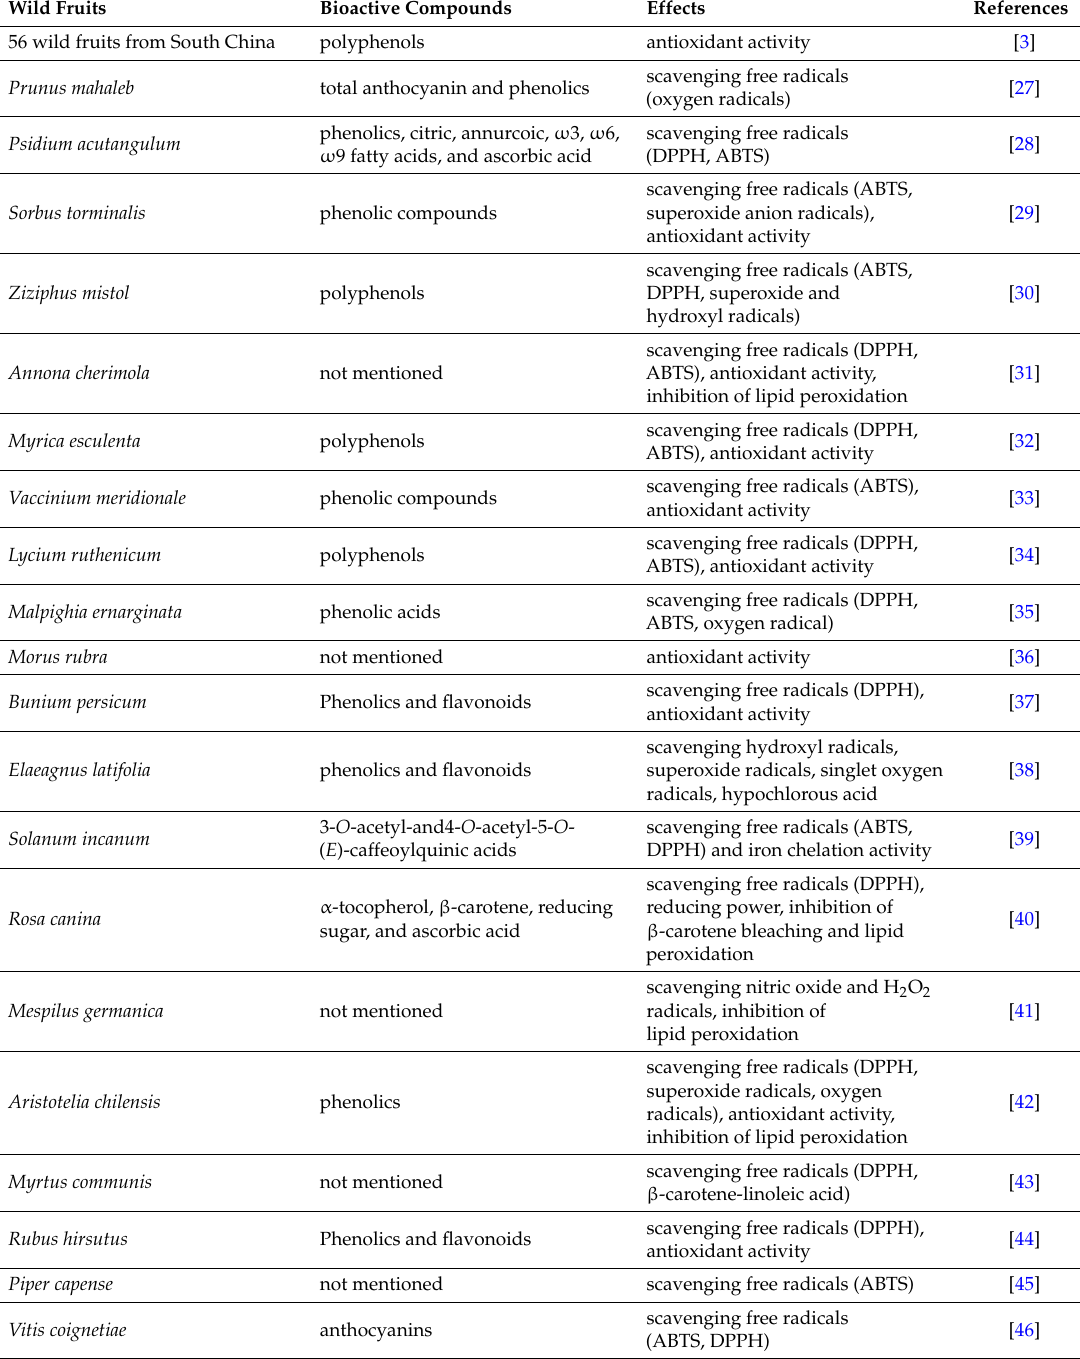
Table 1. Antioxidant activities of some wild